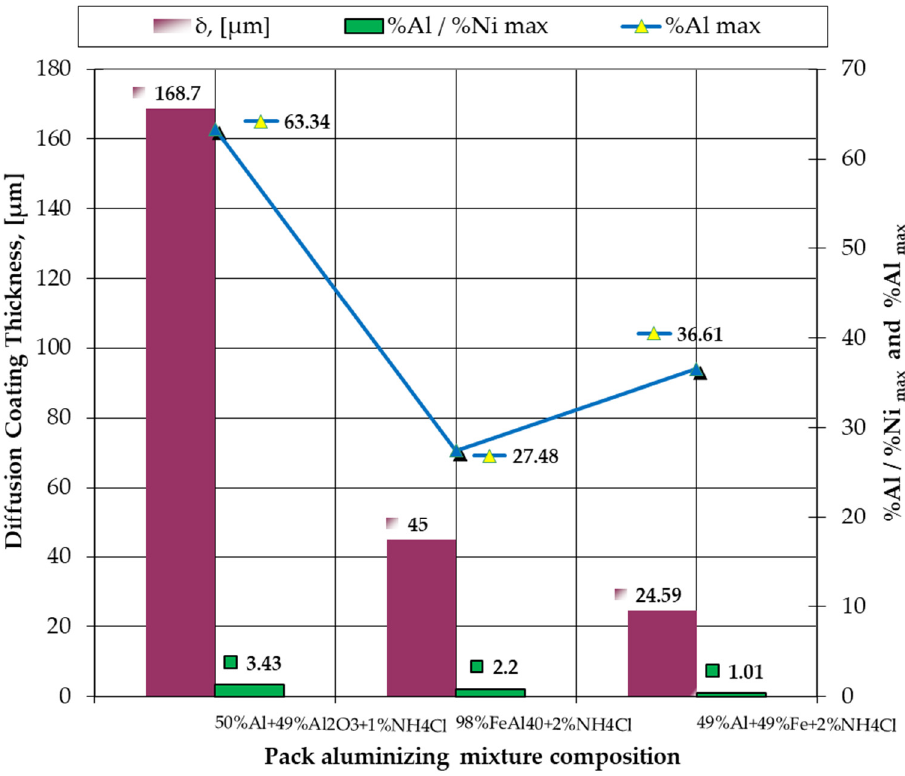
Figure 12. The effects of the change in the phase composition of the pack aluminizing mixture on the diffusion coating thickness and the %Al/%Ni ratio in the top diffusion coating on IN 718 by pack cementation; pack cementation process: holding at 900 °C for 5 h, and slow cooling. Table 2. Comparative analysis of the results of pack cementation with the active components in various states (free, bonded or in the bonded process) of the IN 718 superalloy (processing param- eters: 900 °C/5 h).